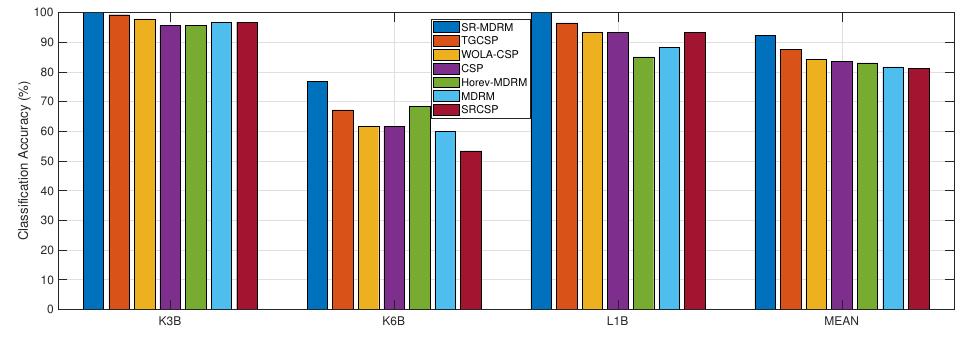
Figure 4. Classification accuracy of the proposed approach and other MI classification approaches on Dataset IIIa, BCI Competition III.